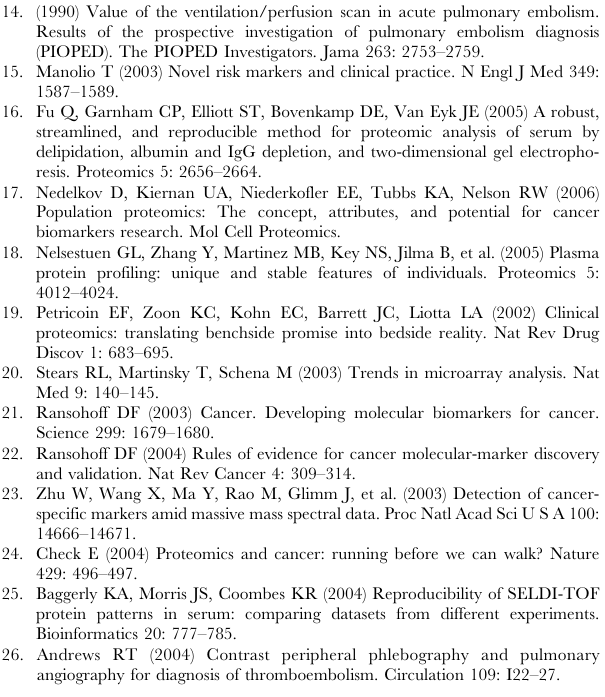
Figure S2 Averaging of mass spectra per patient. For 4 different patients studied, the 14 raw mass spectra are shown, with the final averaged spectrum below each set of raw mass spectra.